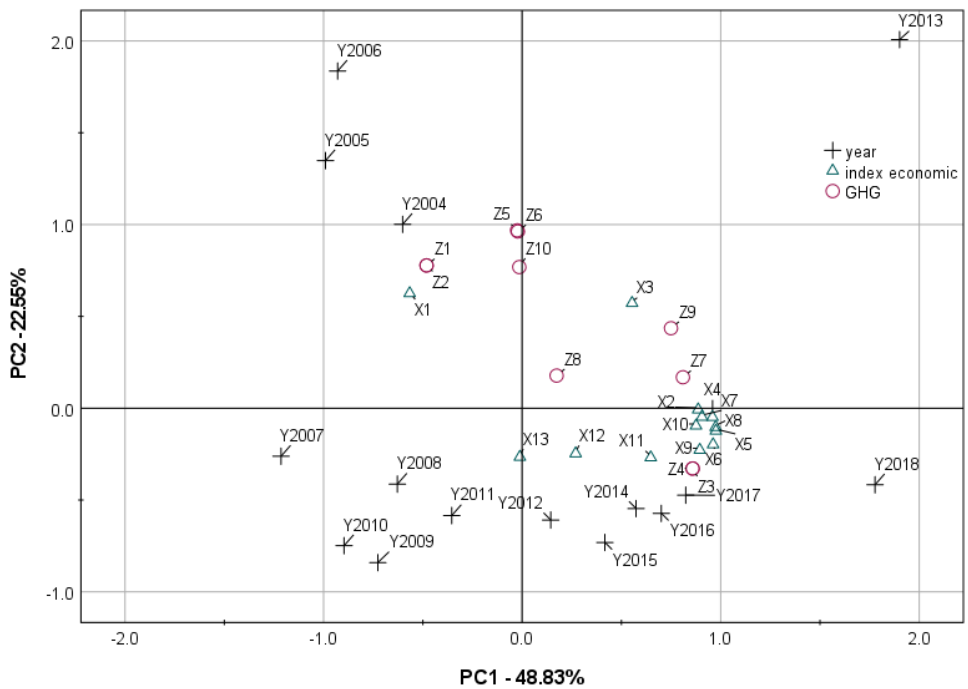
Figure 5. Relationships of locations of studied GHG emission sources (Z 1 .... Z 10 ) and economic indicators (X 1 . .... X 13 ) for mixed production farms in the studied years (Y2004 .... Y2018) in the space of the first two components, PC1 and PC2.